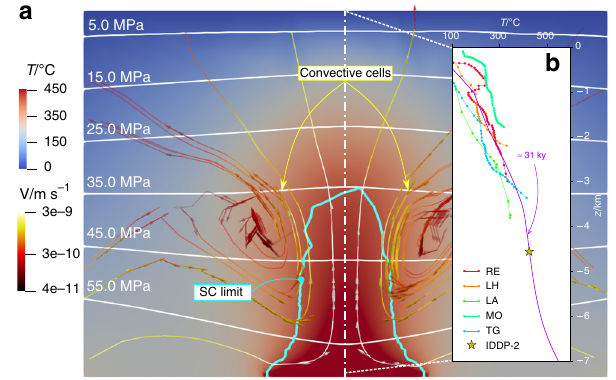
Fig. 3 Initial conditions in the reservoir. a The solution of the hydro-thermal (TH) problem refers to a time of roughly 31 ’ 000 yr. Instability triggers two convective cells and supercritical resources are found in the deeper area and are delimited with a cyan line. b The temperature pro fi le is compared with several geothermal wells in the world close to or at supercritical conditions, (MO) 60 , The Geysers (TG) 17 and IDDP-2 at Reykjanes